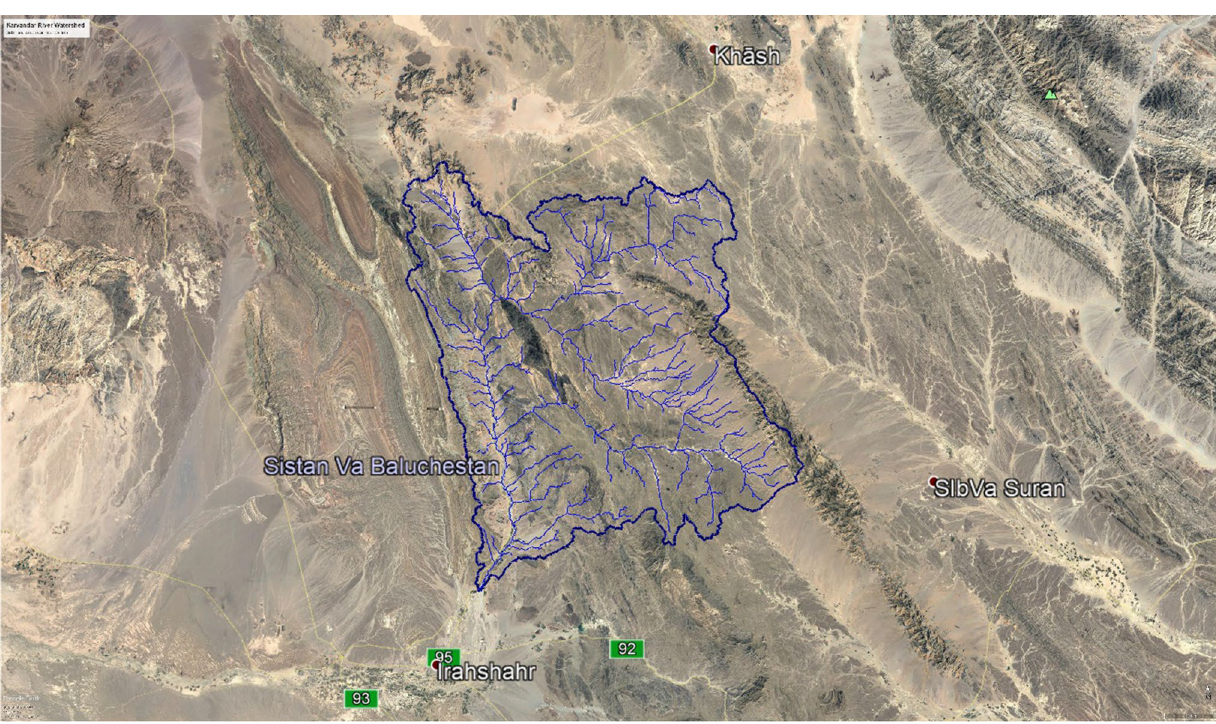
Fig. 8 3D view of the physiographical model of Karvandar River watershed on Google Earth Image located in the arid zone in the north of Iran-